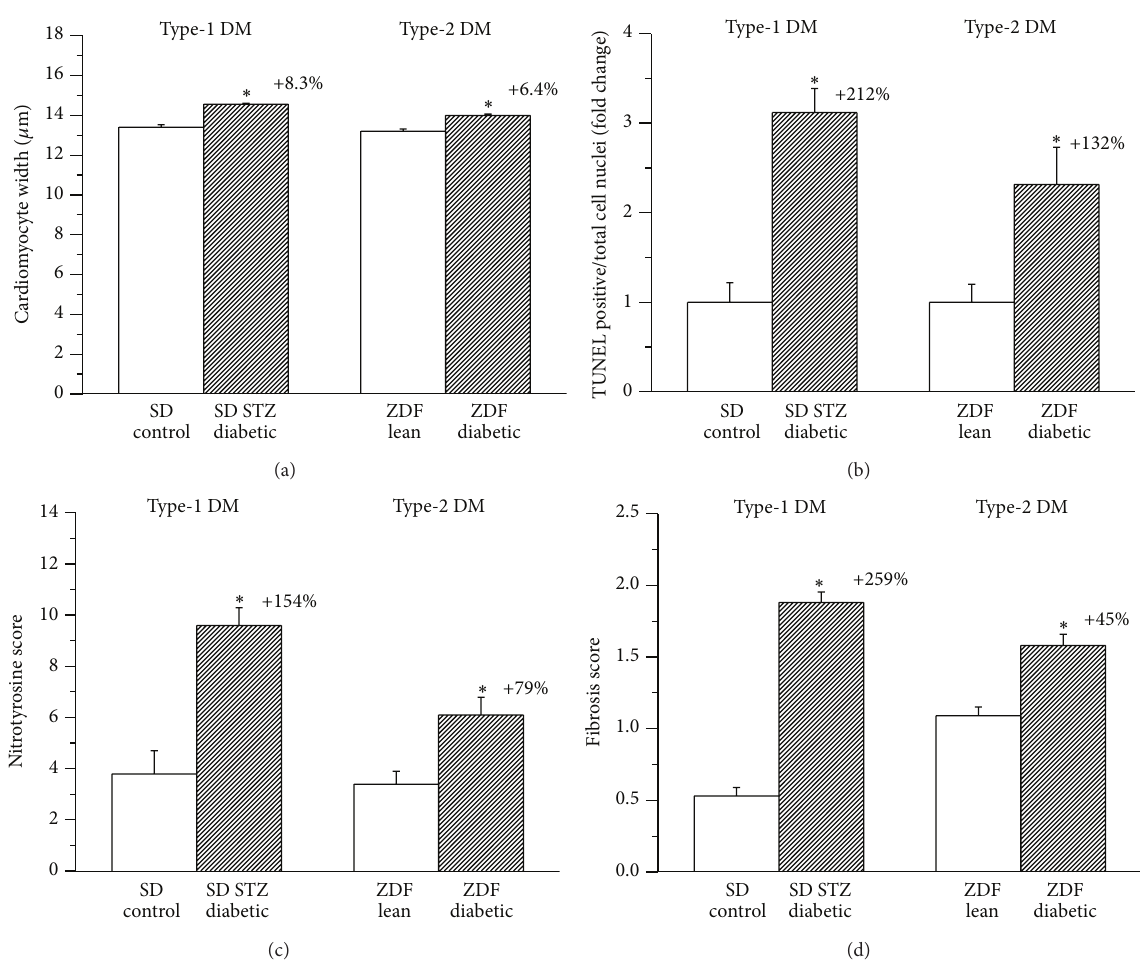
Figure 3: Quantification of histopathological changes of the myocardium in type-1 and type-2 diabetes mellitus (DM) models. Mean cardiomyocyte width as marker of myocardial hypertrophy (a), fold change in the number of TUNEL-positive/total cardiomyocyte nuclei (b), semiquantitative histomorphological scoring of nitrotyrosine immunostaining (c), and Masson’s trichrome fibrosis staining (d) in the groups of SD control, streptozotocin- (STZ-) induced diabetic SD, Zucker Diabetic Fatty (ZDF) lean, and ZDF diabetic rats. Bar graphs represent mean ± SEM. Percent changes between diabetic and corresponding nondiabetic control groups are indicated in both DM models. ∗ : 𝑃 < 0.05 versus the corresponding nondiabetic